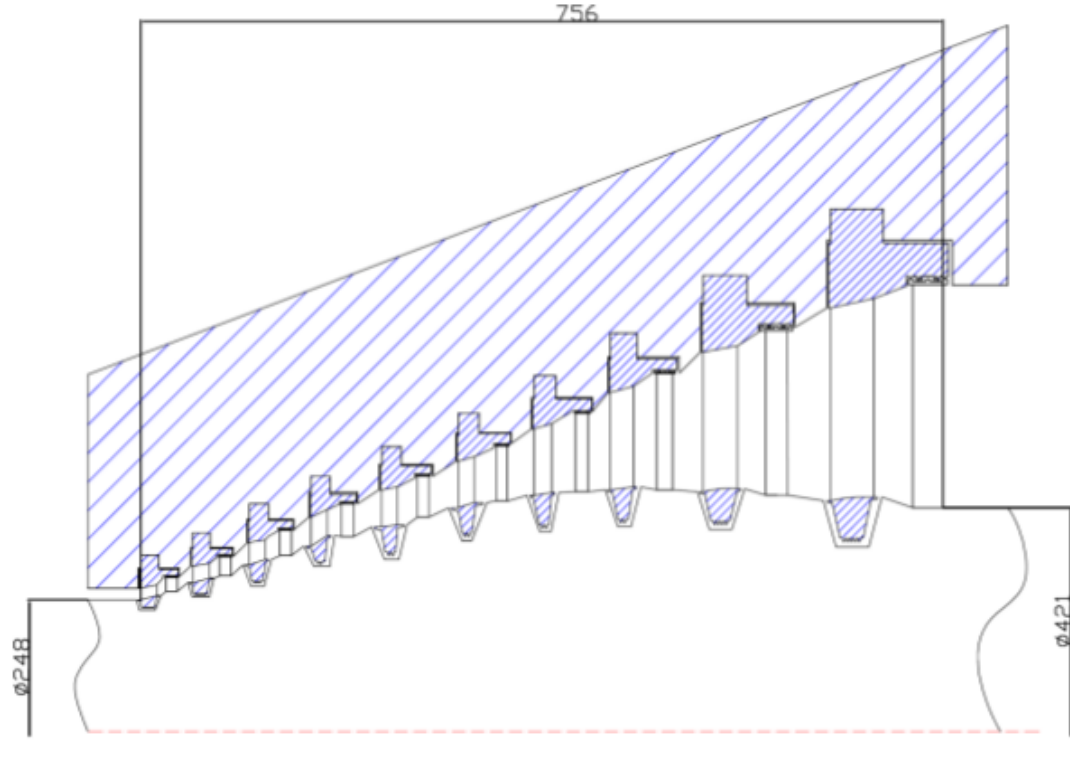
Figure 20: Meridional view of the 500 kW axial turbine.